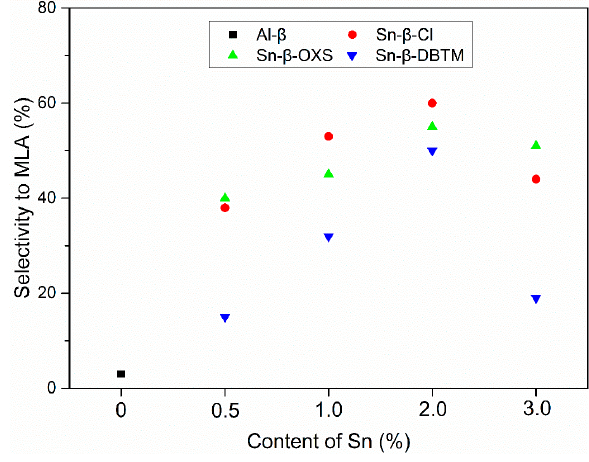
Figure 5. The effect of Sn on the GLY oxidation.